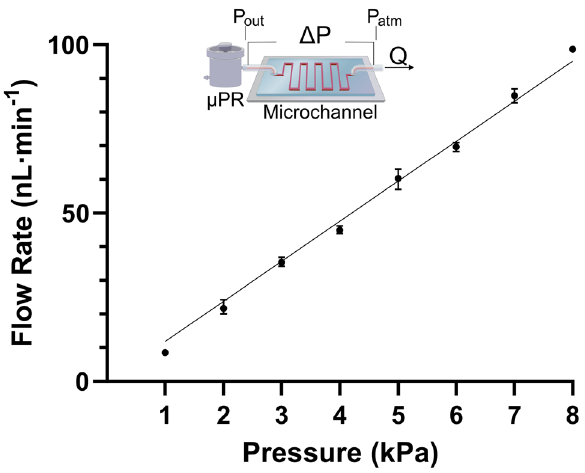
Figure 5. The inset shows the test setup, including the pressure regulator that creates a ∆P across the microchannel. ∆P is determined by the outlet pressure of µPR and the atmospheric pressure at the end of the microchannel. ∆P (1 to 8 kPa) covers flow rates from 8.50 to 98.7 nL min −1 , with the relationship described by the slope 12 nL min −1 kPa −1 . The straight line is the simulated response of flow rates vs. the outlet gauge pressures. R 2 = 0.999 is the correlation between the experimental data and the COMSOL simulation